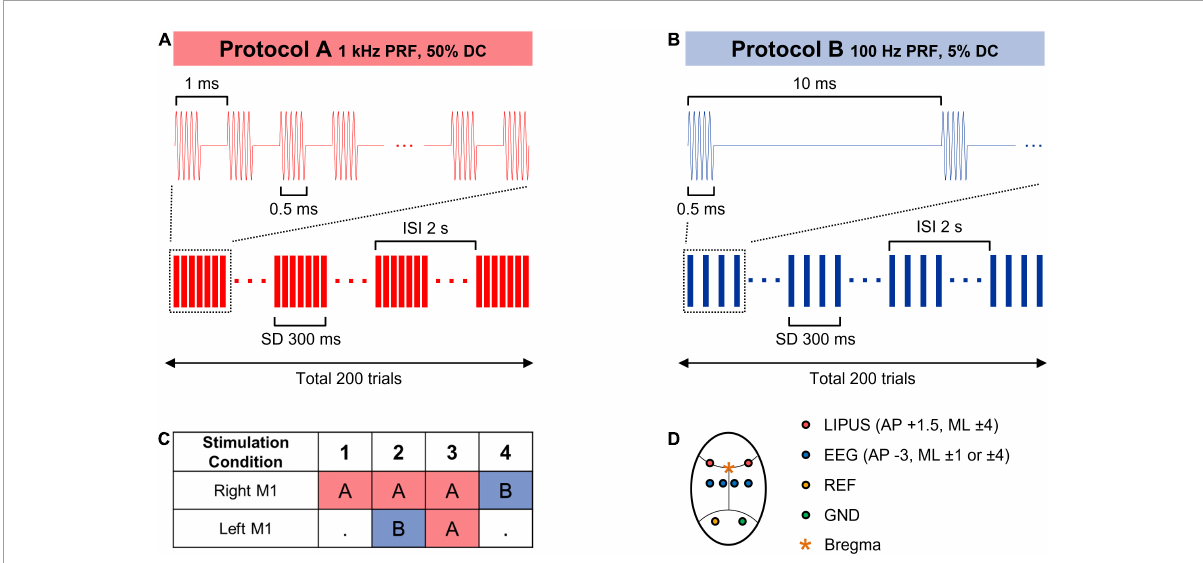
FIGURE2 (A,B) Sonication parameters for the LIPUS stimulation. (C) Combinations of sonication parameters for unilateral (1, 4) and bilateral (2, 3) primary motor cortex stimulation. (D) A schematic diagram of LIPUS stimulation and EEG recording